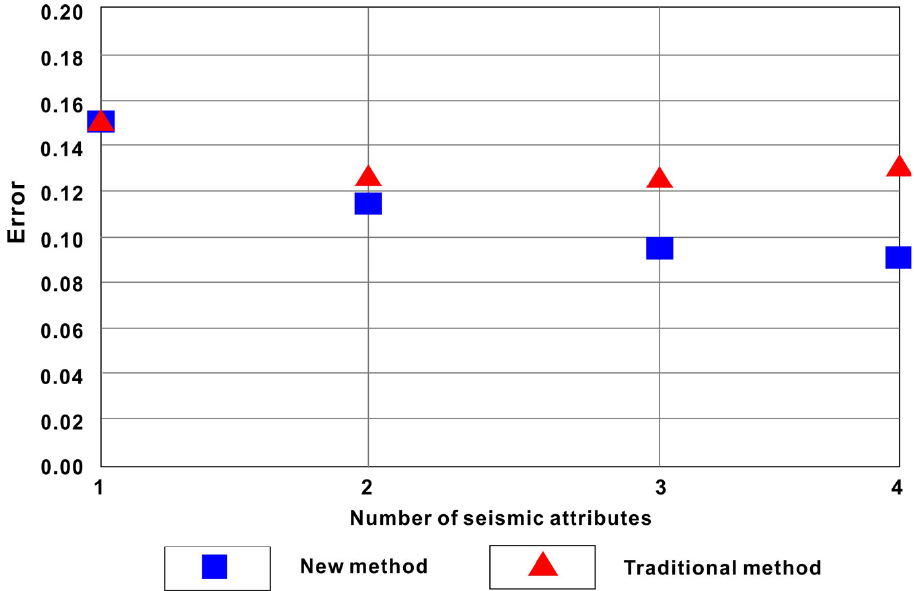
Figure 16. Errors of the traditional and new method varying with the number of secondary data.